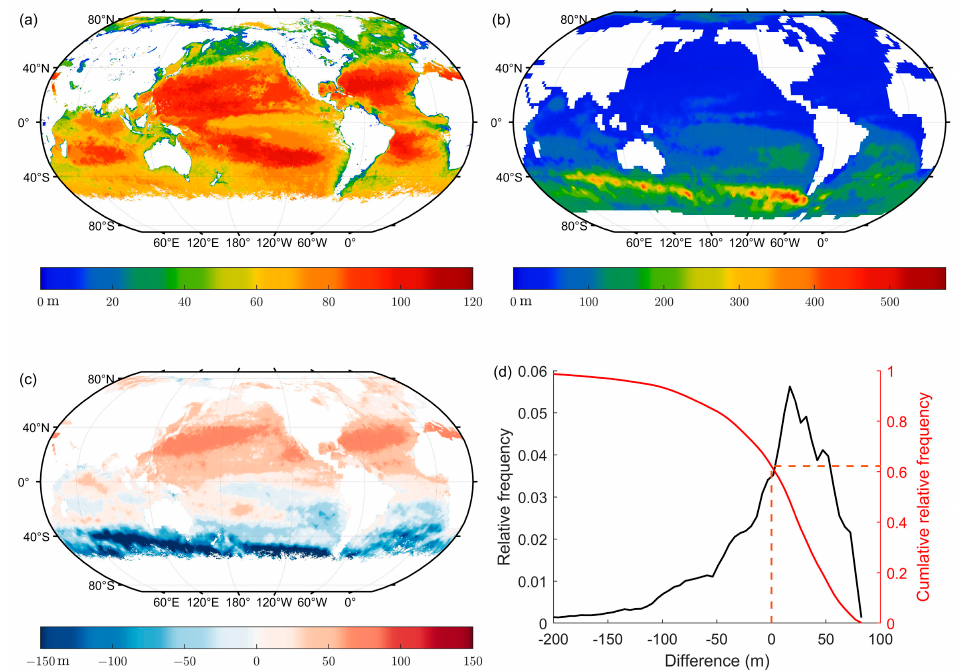
Figure 22. Comparison between lidar maximum detectable depth and MLD in the summer (the northern hemisphere). Distribution of the lidar maximum detectable depth at daytime ( a ), mixed layer depth ( b ), the difference between lidar maximum detectable depth and mixed layer depth ( c ), and the relative frequency distribution of the difference ( d ).